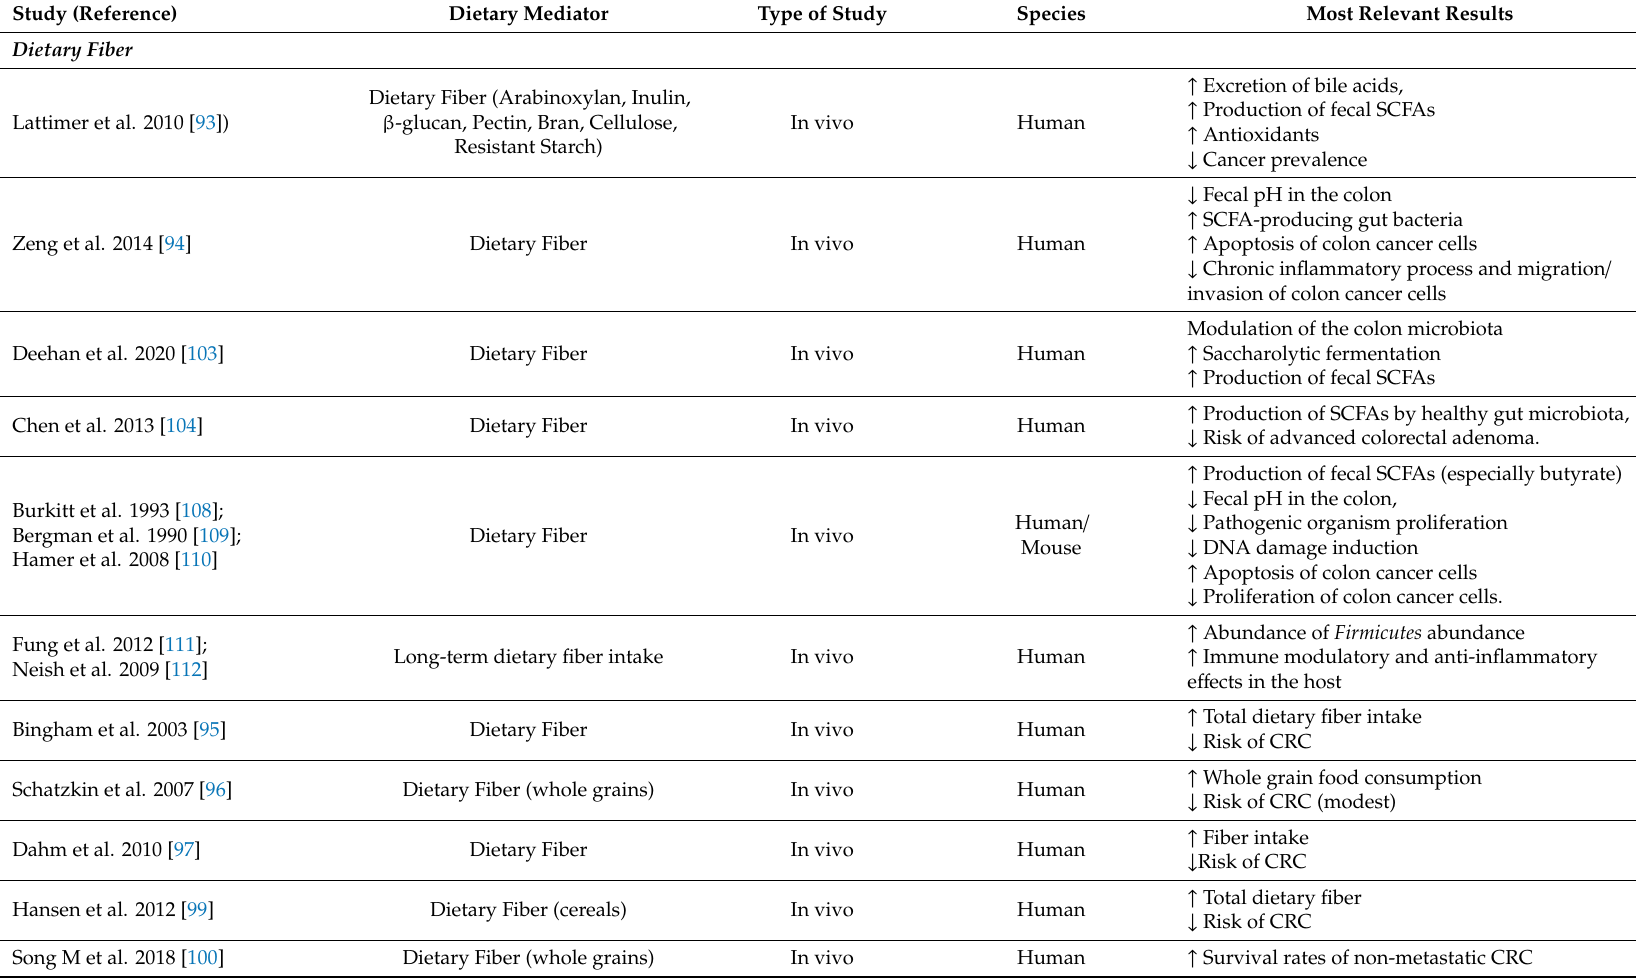
Table 1. Interactions between dietary mediators, gut microbiota and